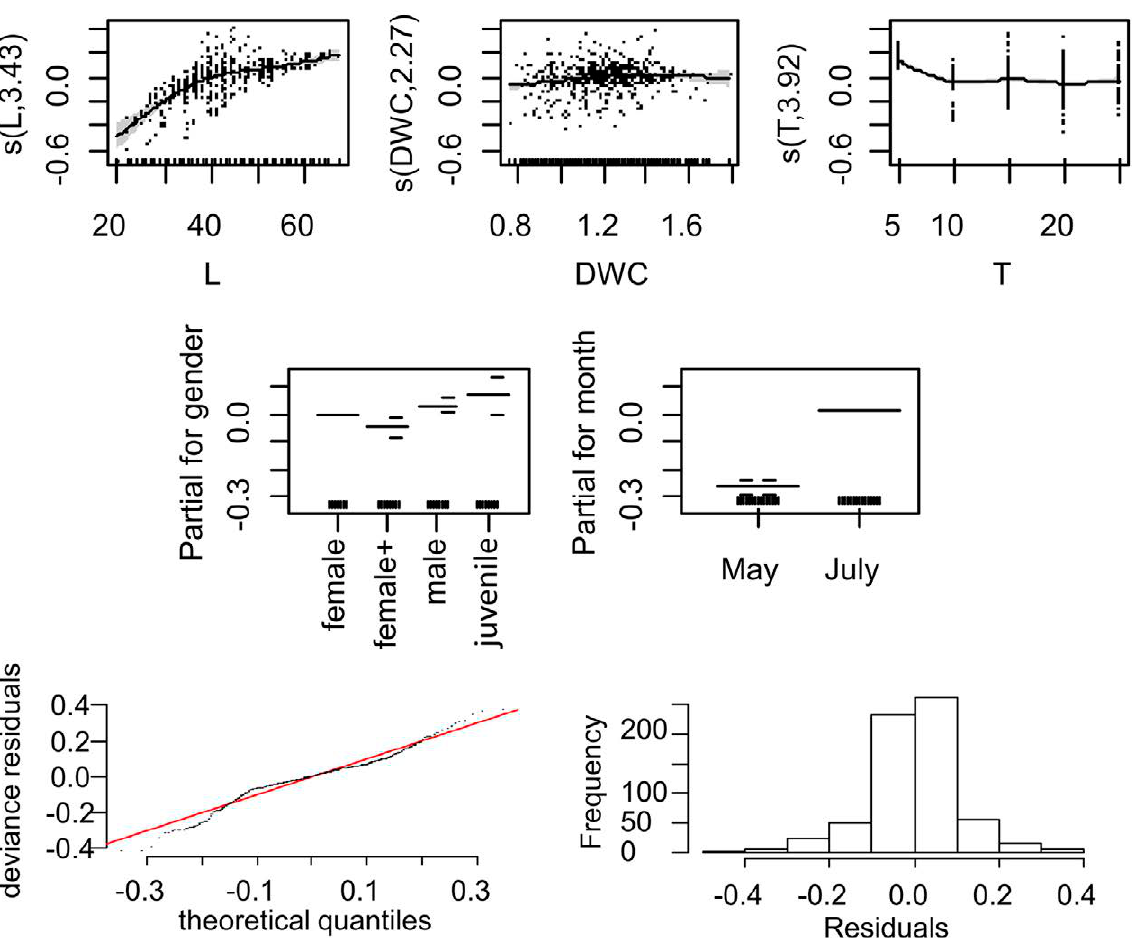
Fig. 4. – Results of the generalized additive model based on the difference between observed growth and predicted growth using the modified Bertalanffy growth model. Partial residuals vs. length (top left), dry weight condition (top middle), temperature (top right), sex (middle left), sampling month (middle right), and distribution of the residuals (lower